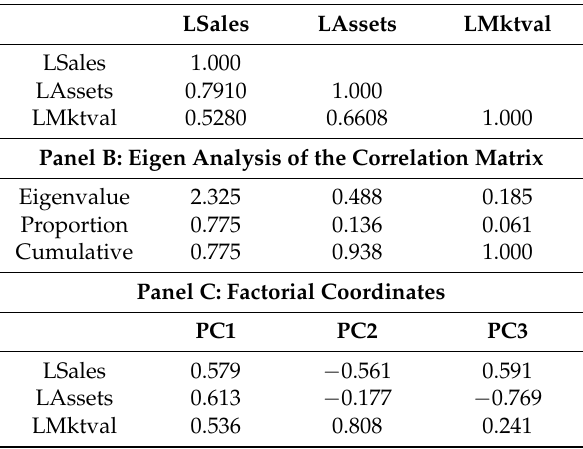
Table 1. Diagnostic tests in